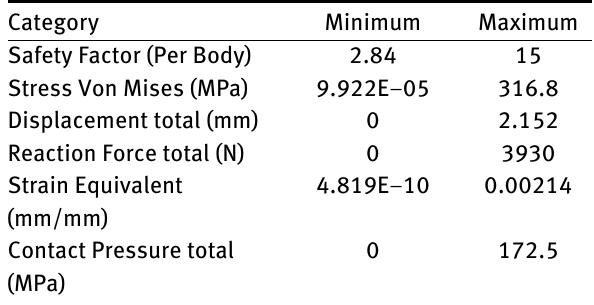
Table 6: Result summary of 0.20 m by 5000 N loaded force Category